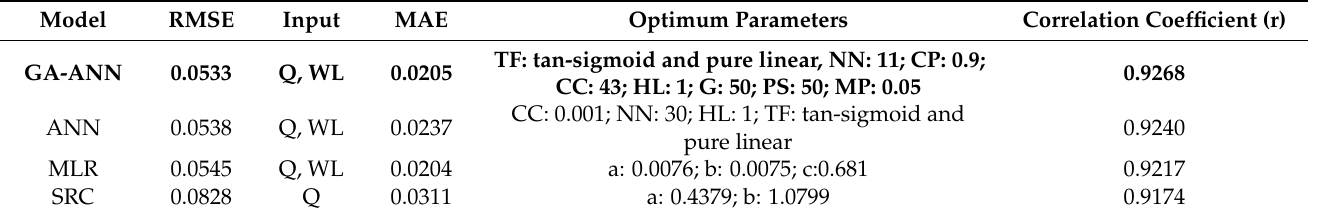
Table 8. Performance comparison of various models with optimum parameters. Bold values show the best results.